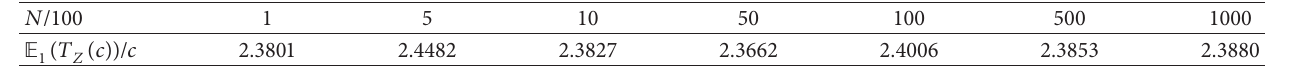
( T ( c )) and c with different choices of N Z 1